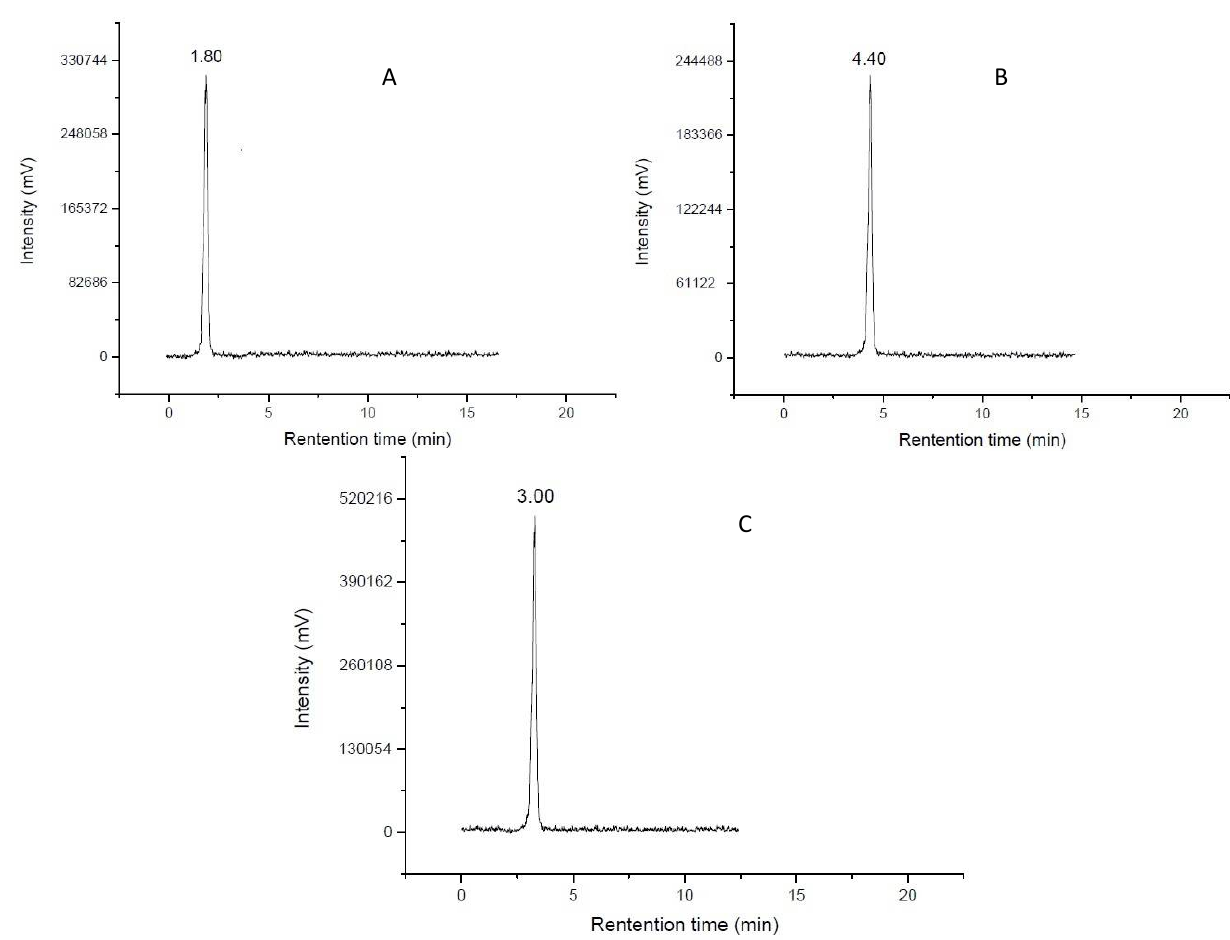
Figure 1. Radio-HPLC